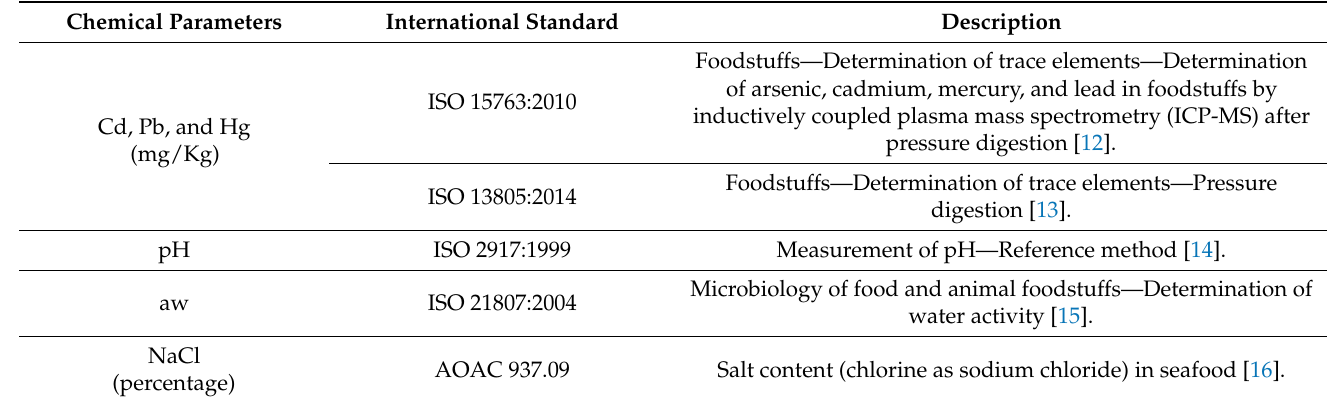
Table 2. Chemical parameters calculated in the present study in accordance with specific interna- tional standards.